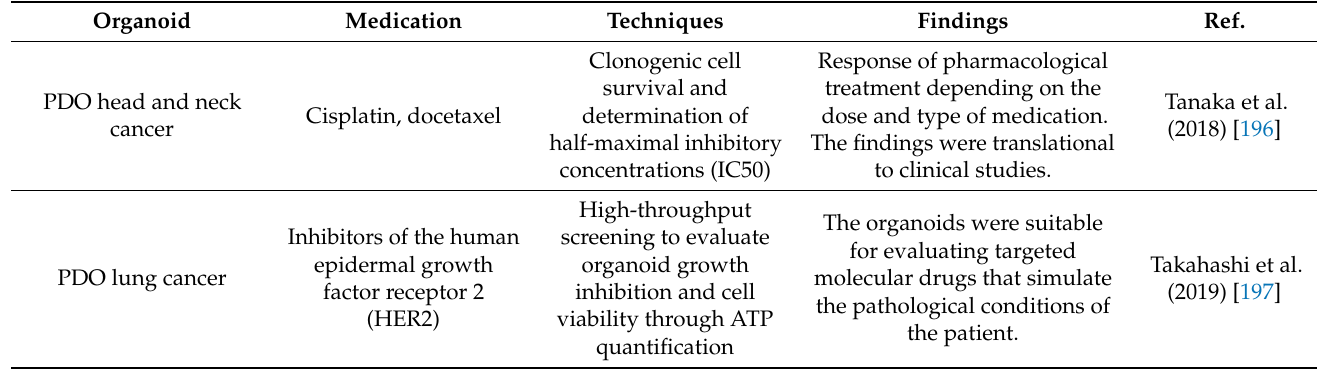
Table 3. Evaluation of anticancer drugs in different types of patient-derived organoids